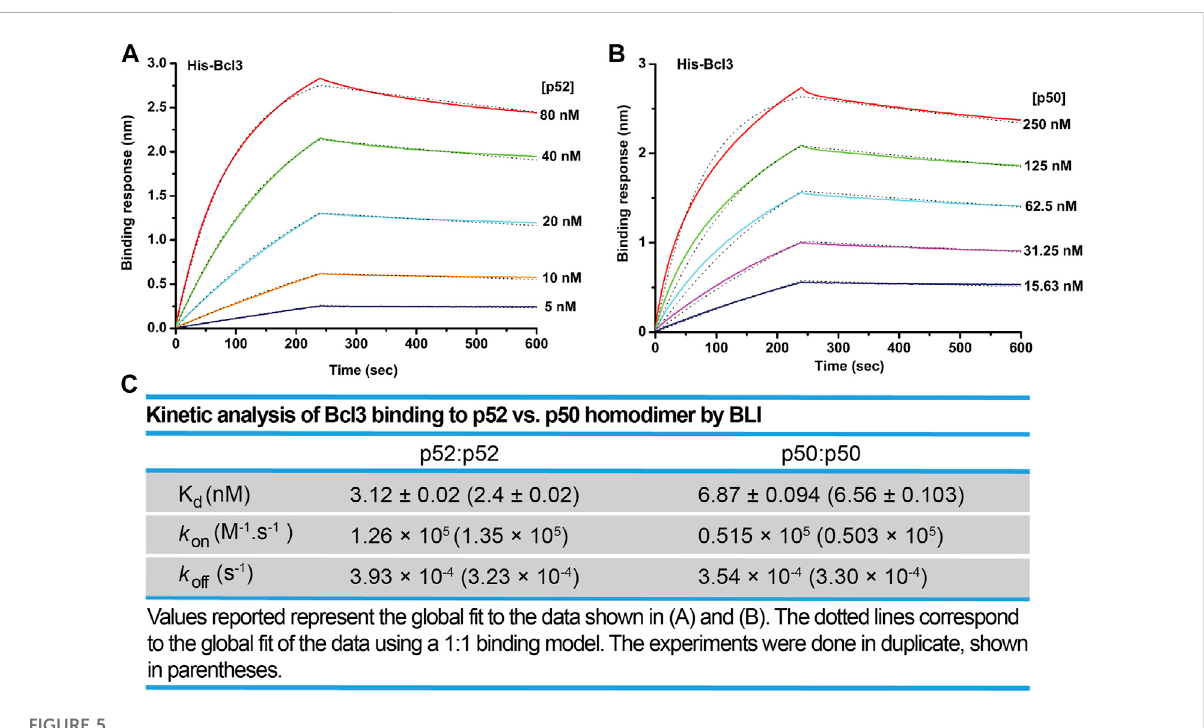
FIGURE 5 Bcl3bindstop52withhigheraf fi nitythanp50.Biolayerinterferometry(BLI)bindinganalysisofrecombinantHis-tagged-Bcl3topuri fi ed (A) p52: p52 and (B) p50:p50 homodimers. Each experiment was performed in duplicate, and one representative set of curves is shown. (C) Table showing the kinetic analysis in (A) and (B)